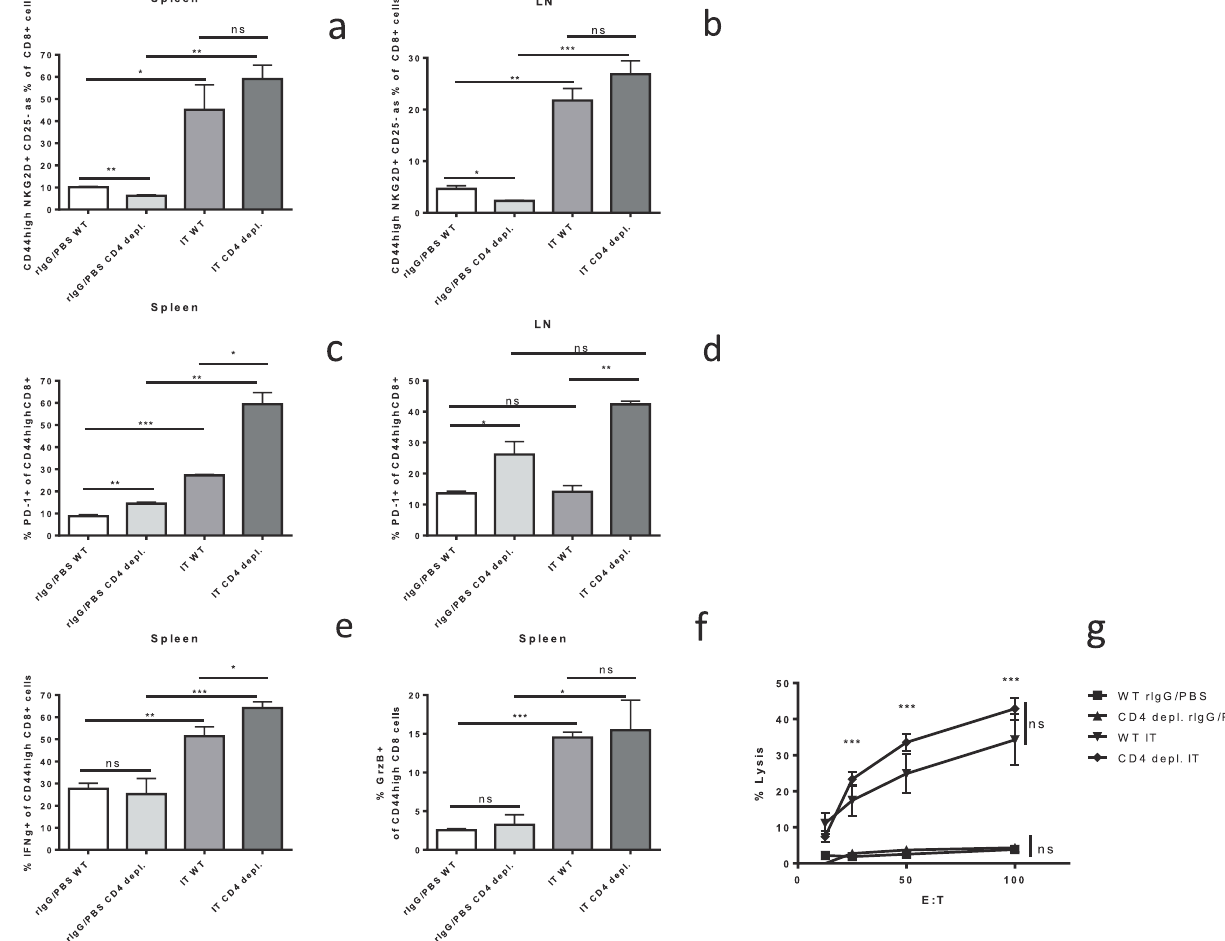
Figure 6. CD4 independence of IT induced bystander activated memory CD8 + T cells persists at longer time points. Control or long term CD4 + depleted C57BL/6 mice were treated with IT or PBS/rIgG (control) and harvested at Day 15 after the initiation of therapy. Bystander memory CD8 + T cells, PD-1 expression, interferon gamma production, and granzyme B production were quantified by flow cytometric analysis. Cytotoxic effector function was assayed by a redirected lysis assay. The percentage of CD8 + T cells with the CD44 high NKG2D + CD25 2 bystander memory phenotype in the spleen ( a ) and LNs ( b ). PD-1 expression on the memory CD8 + T cells in the spleen ( c ) and LNs ( d ). Interferon gamma production ( e ) and granzyme B expression ( f ) in splenic memory CD8 + T cells. ( g ) Killing function of splenocytes from long term CD4 depleted mice expressed as percentage of maximal lysis. N=3 mice per group (* P , .05, ** P , .01, *** P , .001).